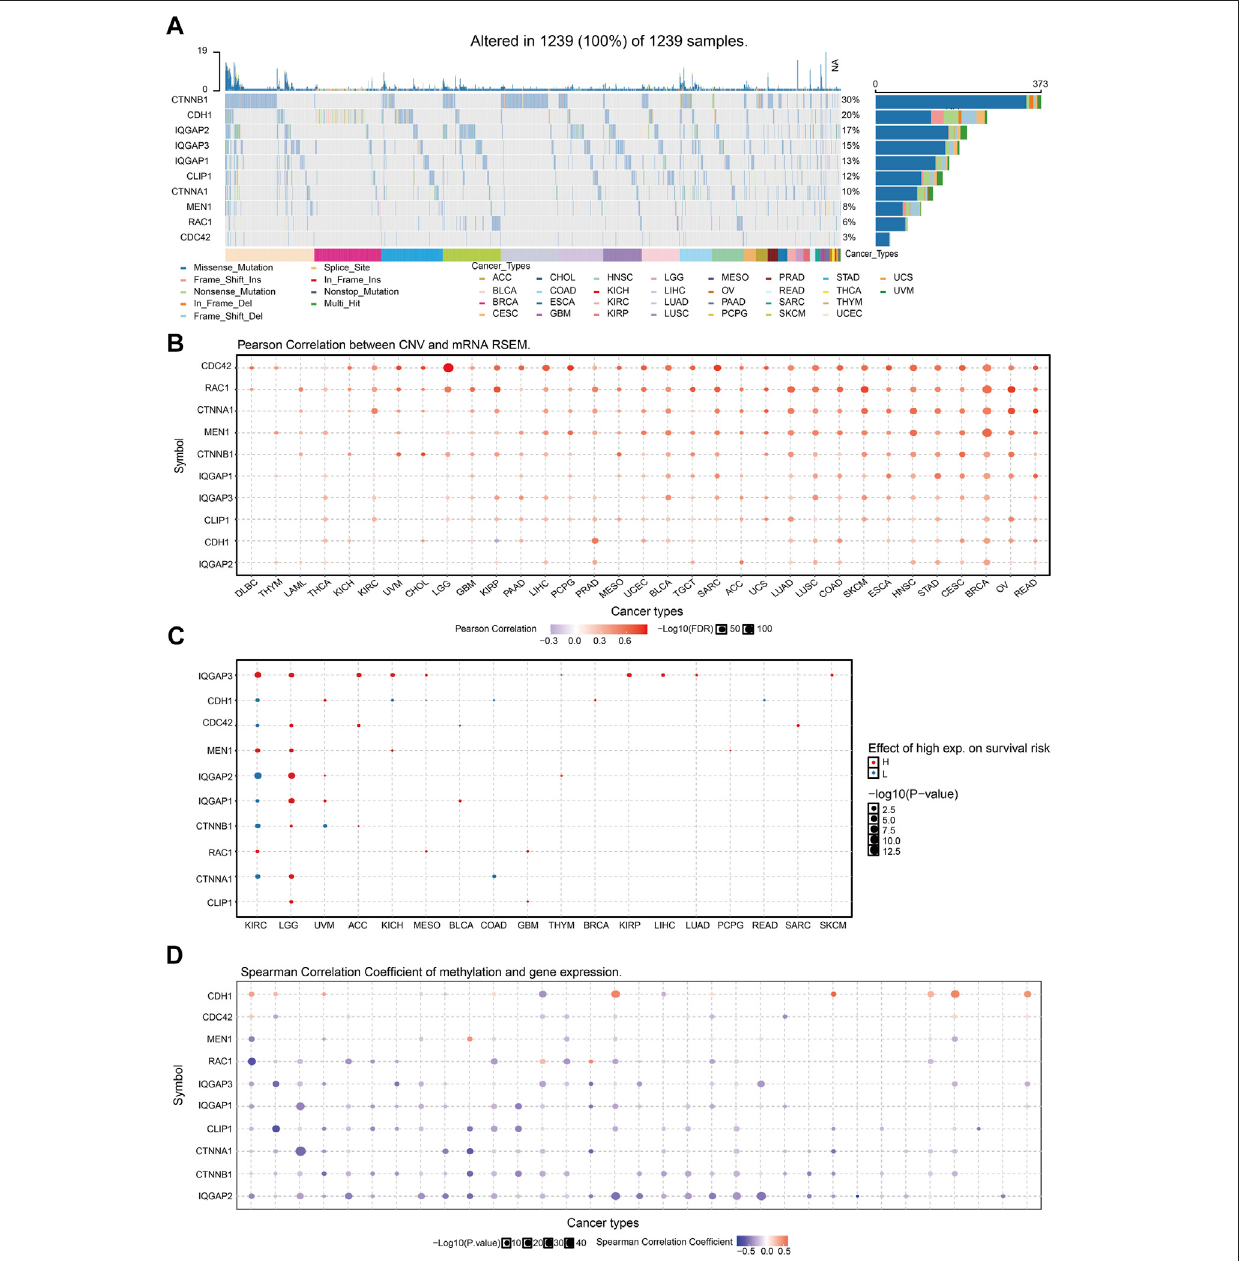
FIGURE 8 | Analysis of the mutation for IQGAP3 interaction with the gene in human cancers. (A) The mutation of IQGAP3 interaction with the gene in human cancers was analyzed by using the GSCA tools. (B) The correlation between CNV and expression of IQGAP3 interaction with the gene in human cancers was analyzed by using the GSCA tools. (C) The correlation between the prognosis and CNV of IQGAP3 interaction with the gene in human cancers was analyzed by using the GSCA tools. (D) The correlation between DNA methylation and expression of IQGAP3 interaction with the gene in human cancers was analyzed by using the GSCA